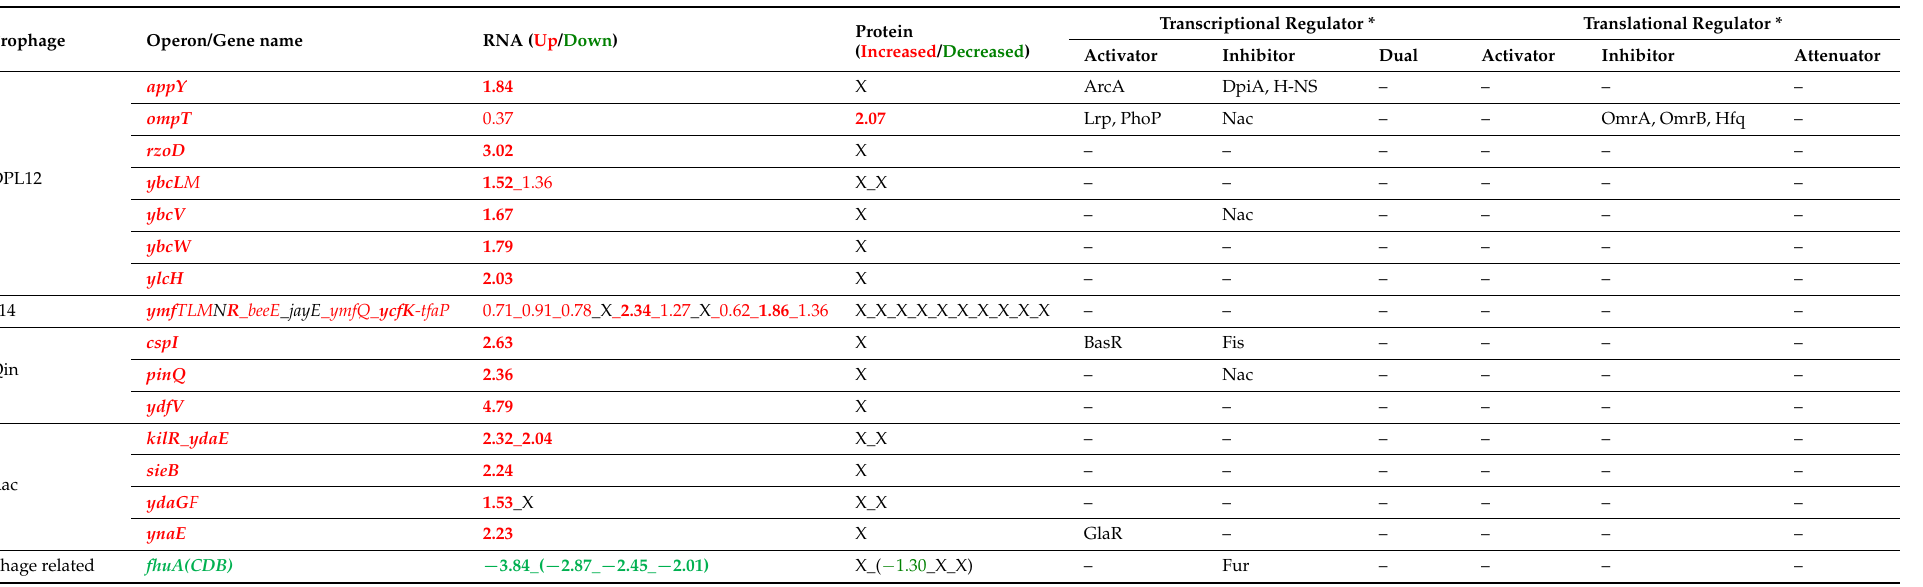
Table 2. Known prophage and phage related gene operons up- and down-regulation under microaerobic versus aerobic